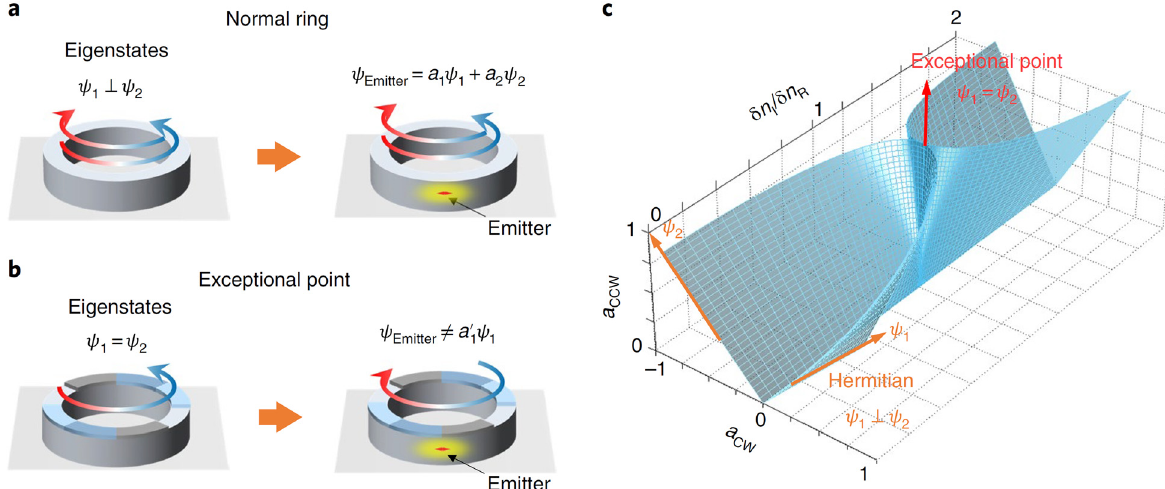
Figure 7: Chirality-reversal radiation at an exceptional point. a A normal ring cavity supports two counter-propagating eigenstates (left). A single emitter at the resonant frequency will excite a standing wave consisting both eigenstates (right). b With parity-time symmetricrefractive indexmodulation,the two eigenstatesbecome identical in a ring cavity at an exceptional point (left). A single emitter can become fully decoupled from the only eigenstate and radiates to the missing dimensionwiththeoppositehandedness(right). c Evolutionofthedirectionsofthetwoeigenstatesofaparity-timesymmetricringcavityasa function of refractive index modulation. Figure adapted